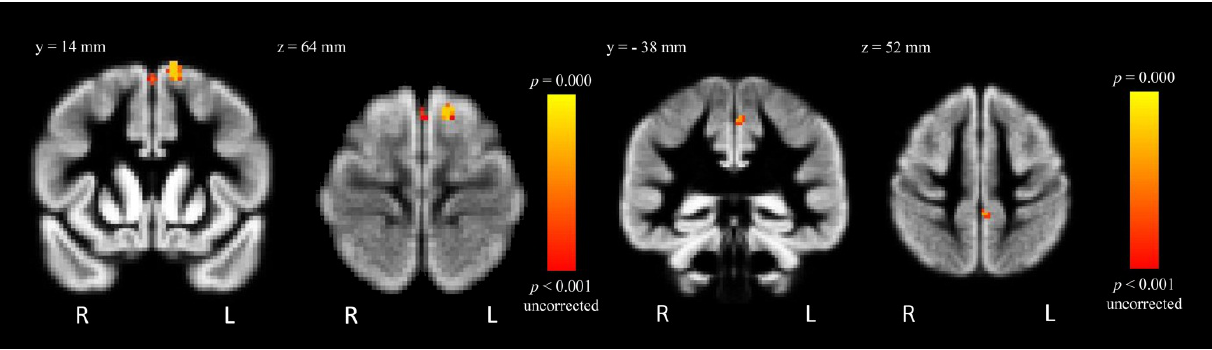
Figure 3. FSL-VBM results from the contrast “Control > MA”, where GMD is decreased for MA-dependent in comparison to control participants within the L SFG (left) and left precentral gyrus (right), p < uncorrected